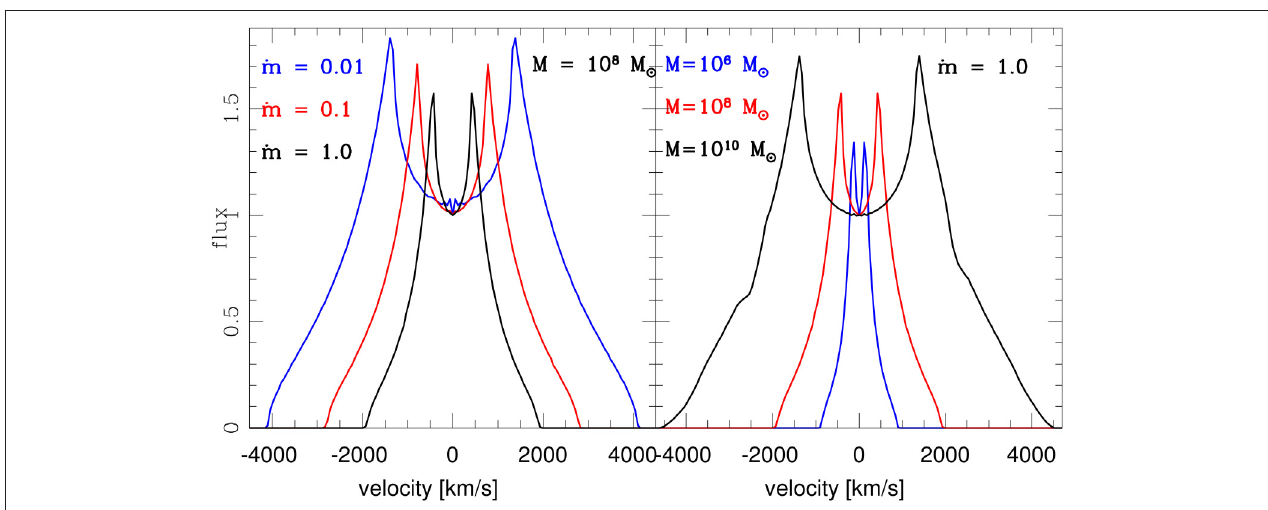
FIGURE 3 | An example of the dependence of the line profile on the accretion rate, for a black hole mass of 10 8 M ⊙ (left) , and on the black hole mass for the Eddington accretion rate (right) . The viewing angle is fixed at 30 deg. The inner and outer BLR radii calculated for the model are: 1.98 × 10 16 cm and 1.87 × 10 17 cm, 4.26 × 10 16 cm and 5.91 × 10 17 cm, 9.18 × 10 16 cm and 1.87 × 10 18 cm in the left panel, and 4.26 × 10 15 cm and 1.87 × 10 17 cm, 9.18 × 10 16 cm and 1.87 × 10 18 cm, 1.98 × 10 18 cm and 1.87 × 10 19 cm in the right panel. Line flux is normalized to 1 at zero